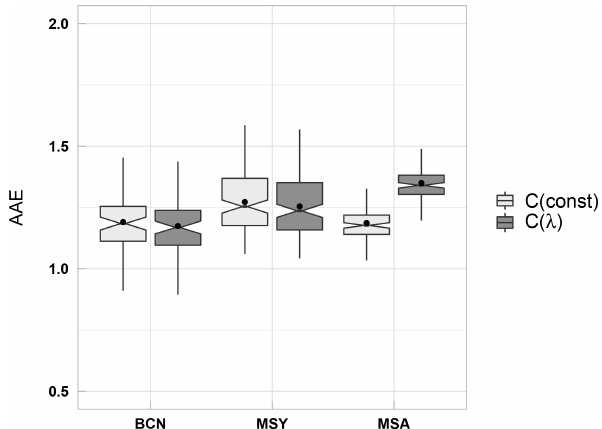
Figure 7. The absorption Ångström exponent (AAE) calculated with a constant C( const ) and the wavelength-dependent C(λ) for all stations. Box plots have been obtained as in Figs. 3 and 4, with the markers indicating the mean AAE